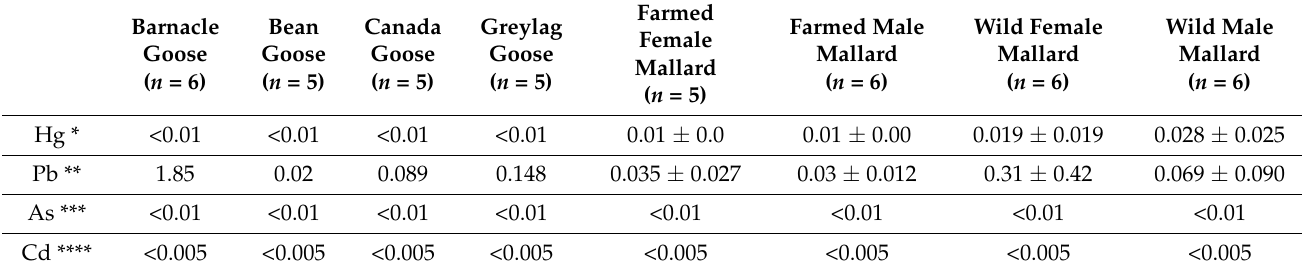
Table 4. Heavy metal content. Mean values in mg/kg ( ± sd) for mallards that were analysed (individually) for mercury (Hg), lead (Pb), arsenic (As), and cadmium (Cd). For each goose species, six breast muscles were pooled and no deviation from the mean could be calculated. No significant differences between any groups were found ( p > 0.126). As no limit values for wildfowl exist, limit values for some various food for each heavy metal are included as reference.